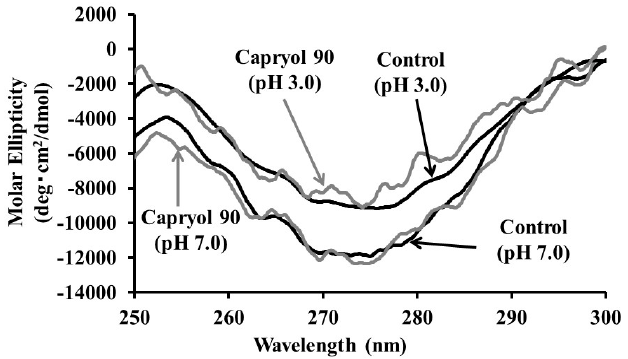
Figure 6. Effects of Capryol 90 and pH on circular dichroic spectra of 0.02 mM insulin. Figure 6. E ff ects of Capryol 90 and pH on circular dichroic spectra of 0.02 mM